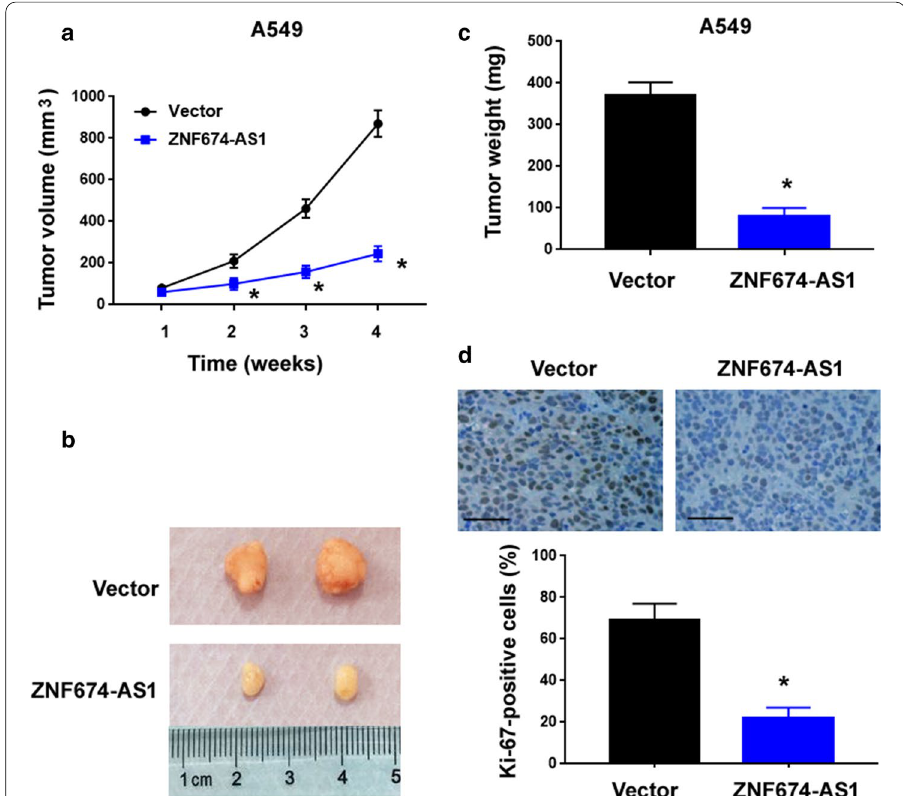
Fig. 3 ZNF674-AS1 blocks tumorigenesis of A549 cells in vivo. a Assessment of the growth of xenograft tumors formed by ZNF674-AS1-overexpressing and control A549 cells. b Photographs of 2 representative xenograft tumors from each group. c Tumor weight was measured 4 weeks after cell inoculation. d Ki-67 immunostaining performed in xenograft tumors. Scale bar 100 μm. Quantitative results of Ki-67 staining are = shown in bottom panel. * P < 0.05 vs.